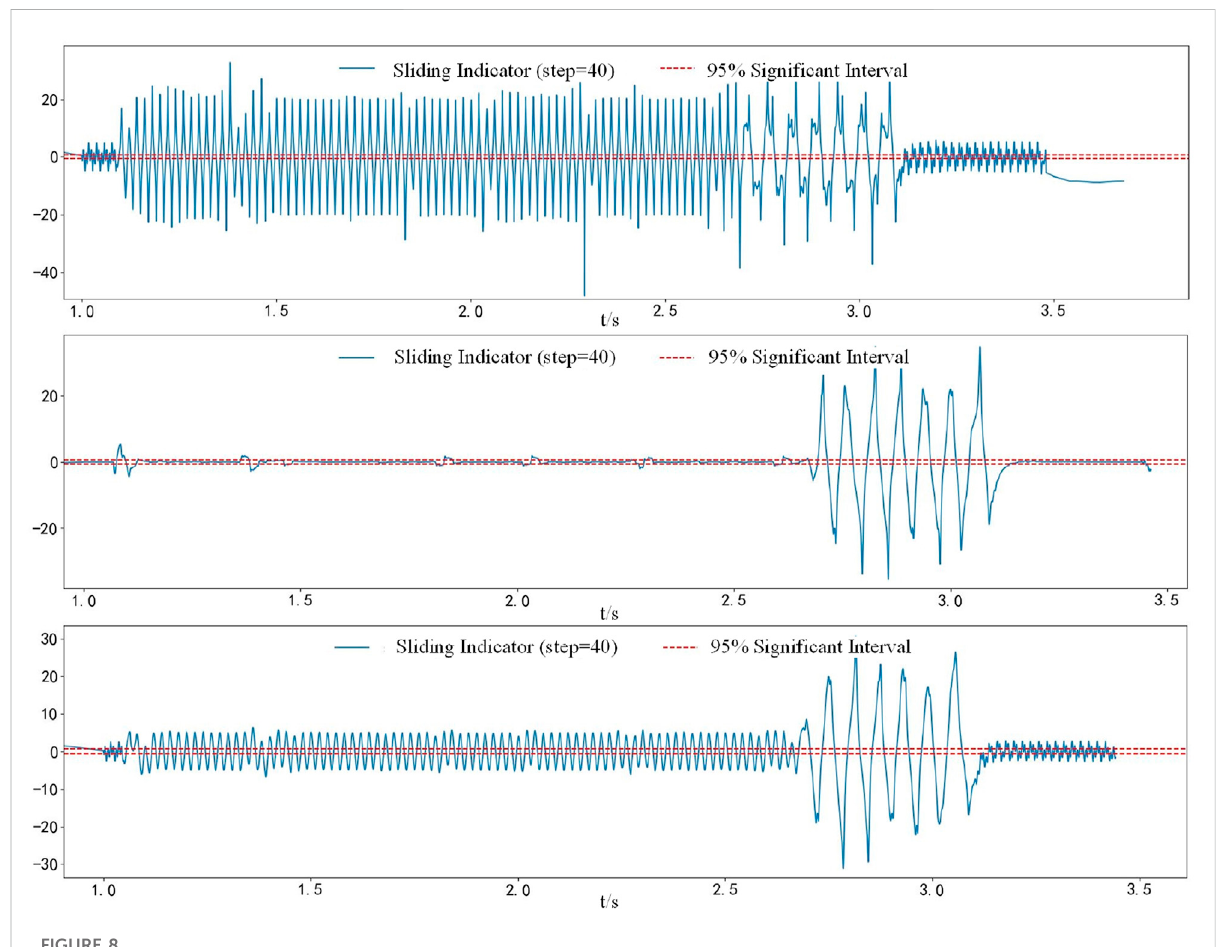
FIGURE 8 Detection results of different sliding